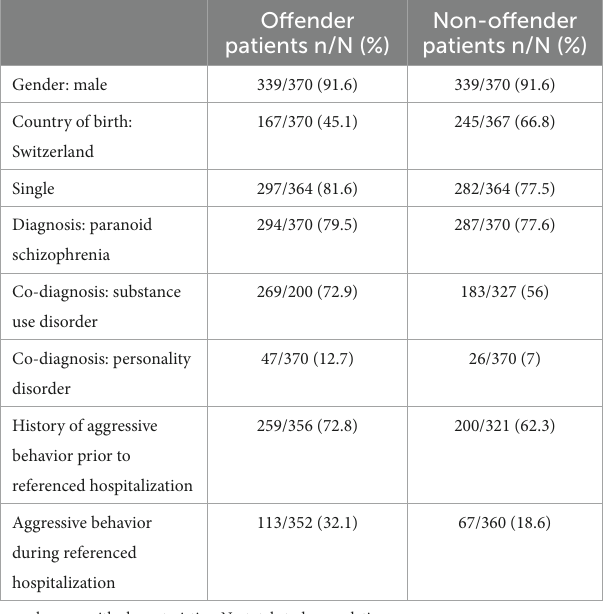
TABLE 2 Descriptive characteristics in both